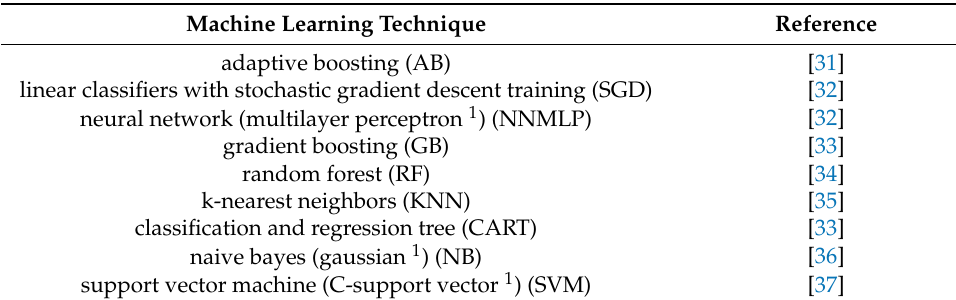
Table 4. Machine learning techniques applied in this study.